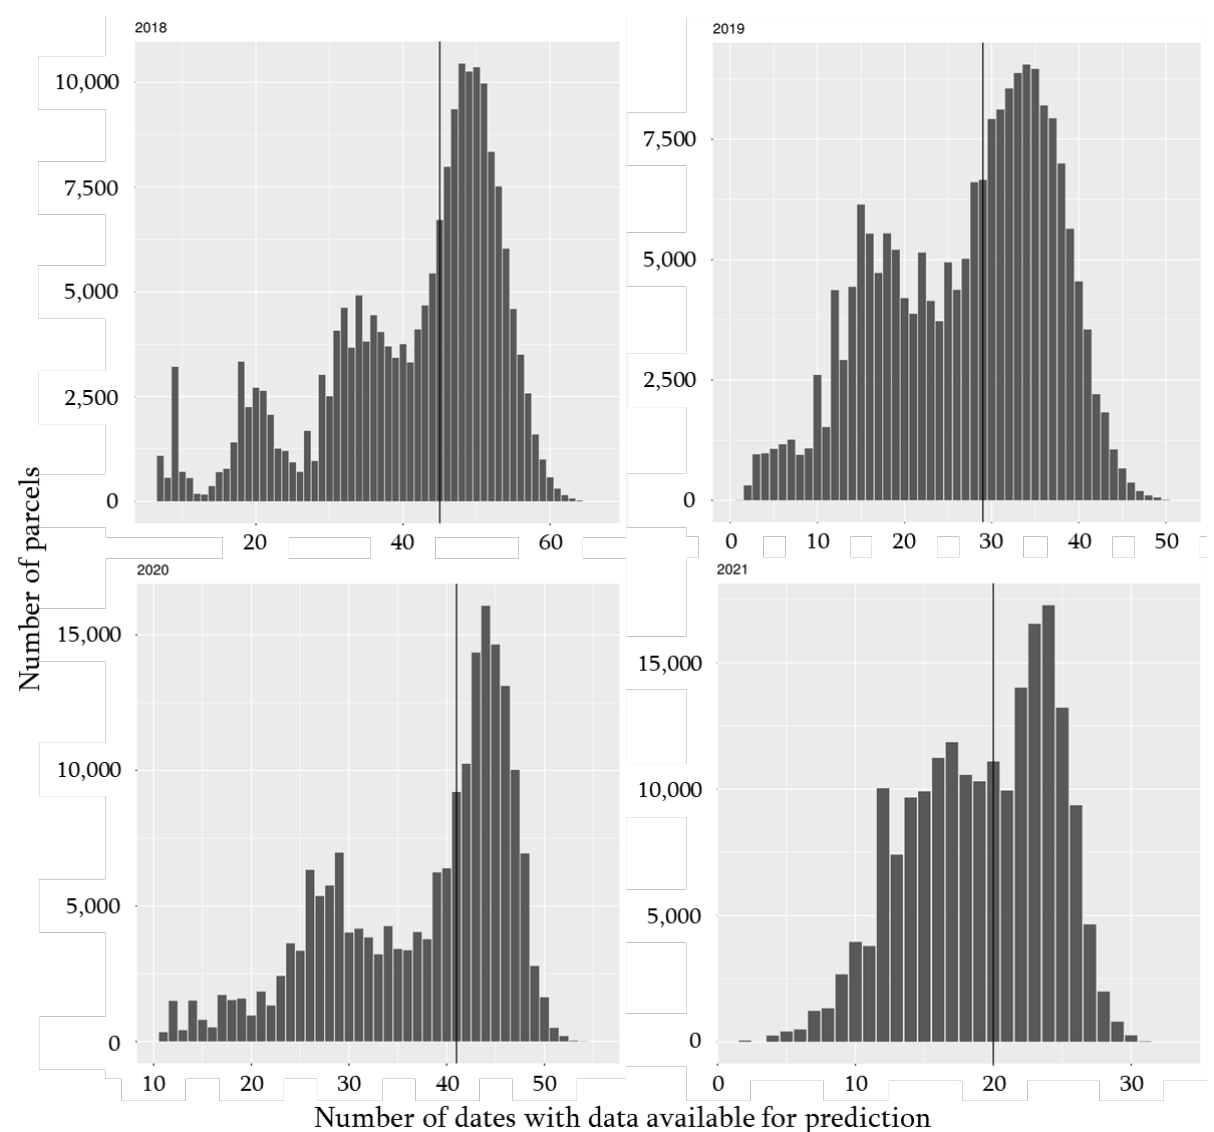
Figure 5. Number of parcels per number of dates with data available for prediction. This may be interpreted as the probability distribution of getting x prediction a year. The vertical lines denote the median number of occurrences.